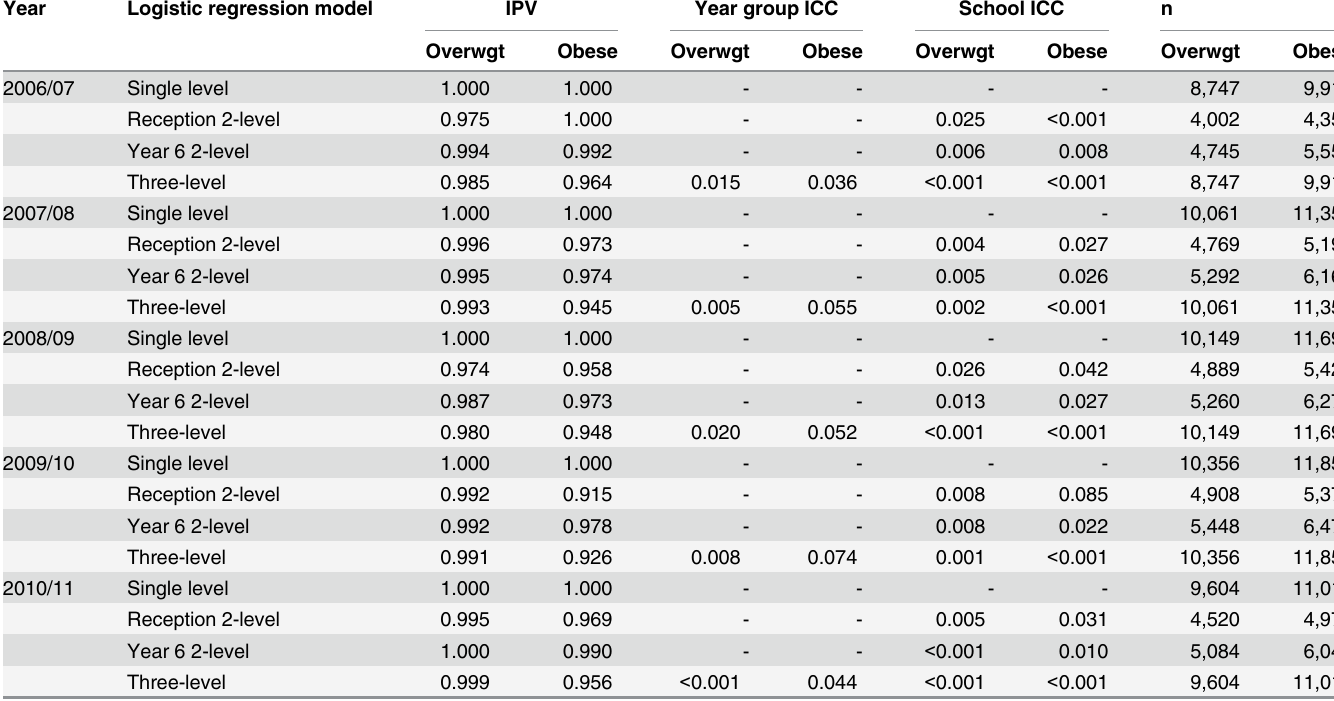
Table 4. Null model intraclass correlation